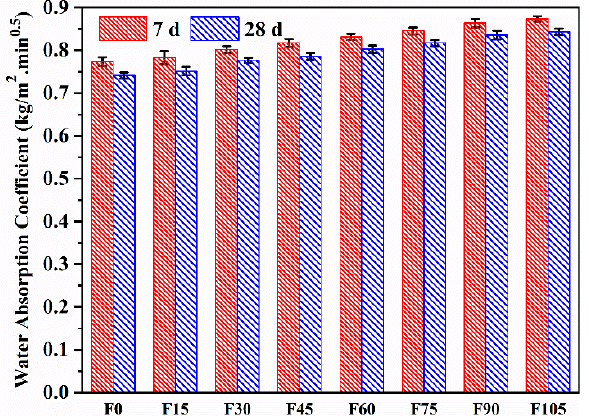
Figure 9. Water absorption coefficients of F0–F105.